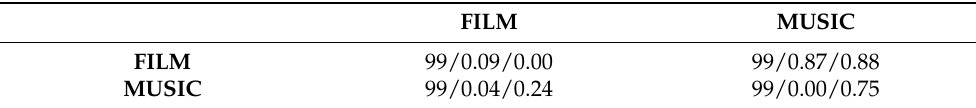
Table 8. ACC, FAR and FRR for the 2nd CNN model